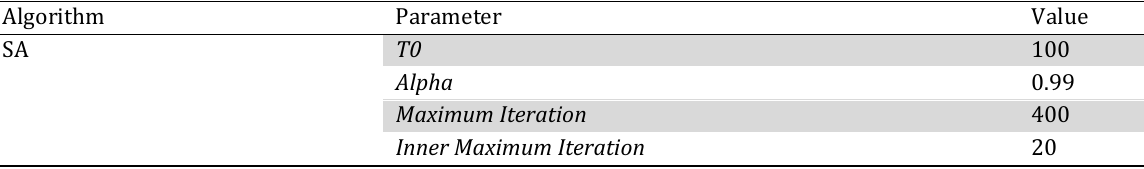
Parameters of SA algorithm